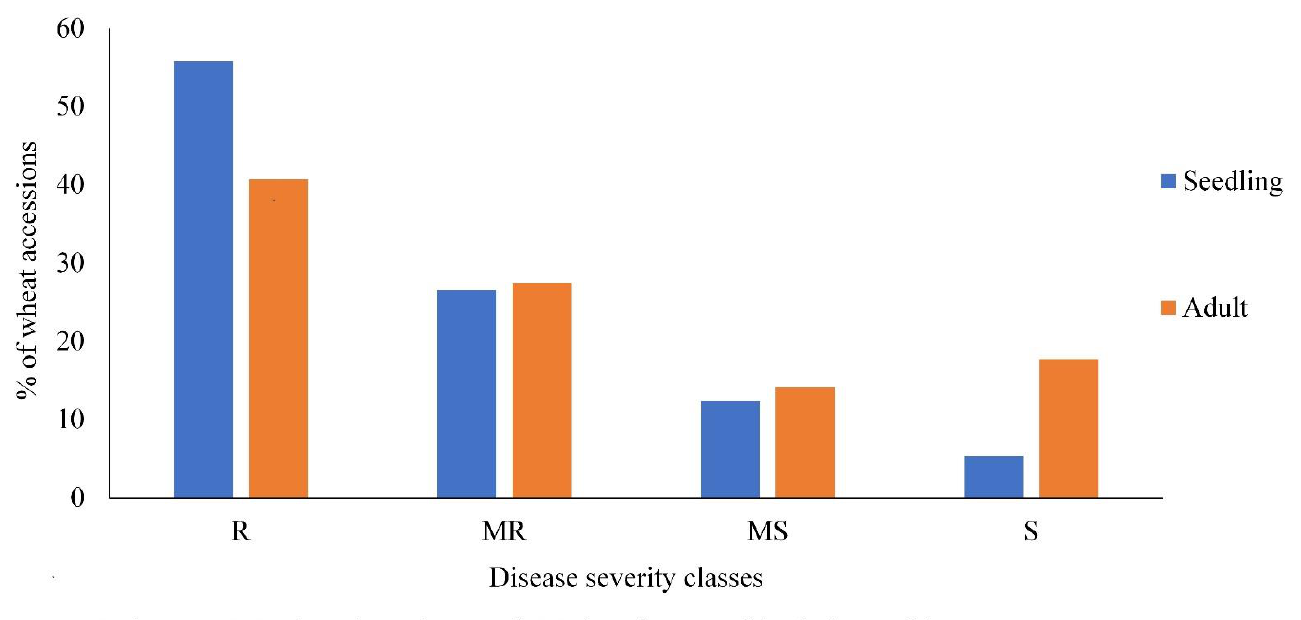
Figure 3. Frequencies of resistance levels (%) of the 113 durum wheat accessions to tan spot disease in the field at seedling and adult stages in the 2018–2019 cropping season.